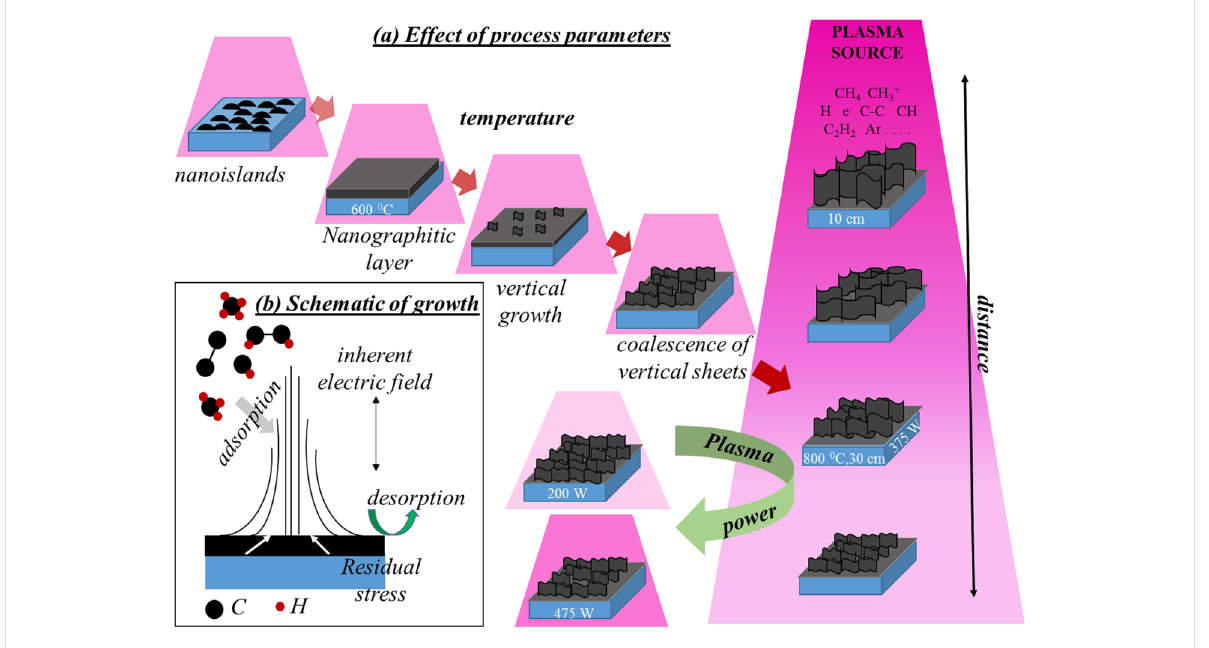
Figure 4: Schematic of (a) effect of process parameters on the growth and (b) growth mechanism of vertical graphene nanosheets.